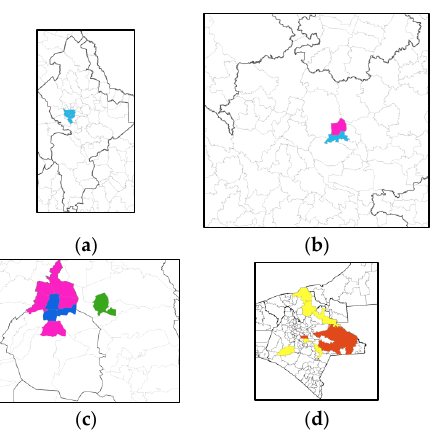
Figure 5. Spatial distribution of municipalities in extreme clusters.